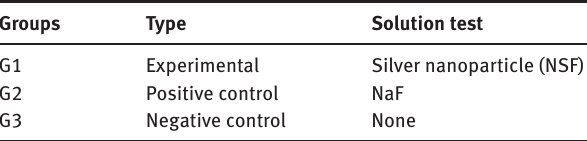
Table 2: Description of the studied groups.